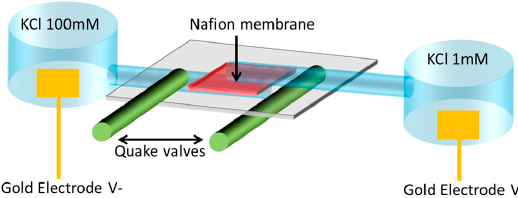
Figure 8. Microfluidic neuron device.